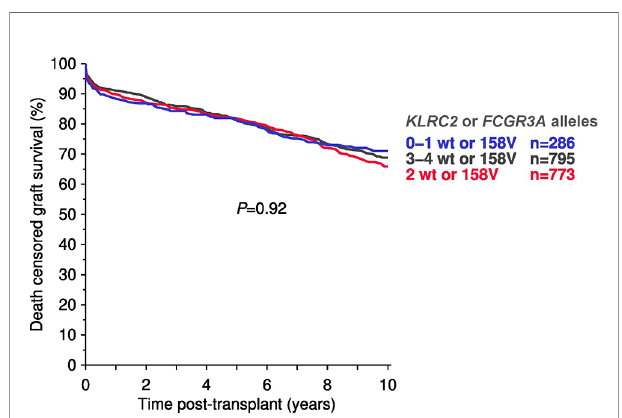
FIGURE 6 | Total number of ‘ risk alleles ’ ( KLRC2 wild type (wt) and/or the FCGR3A -V158 polymorphism) in the Collaborative Transplant Study (CTS) cohort in relation to 10-year death-censored graft survival (total